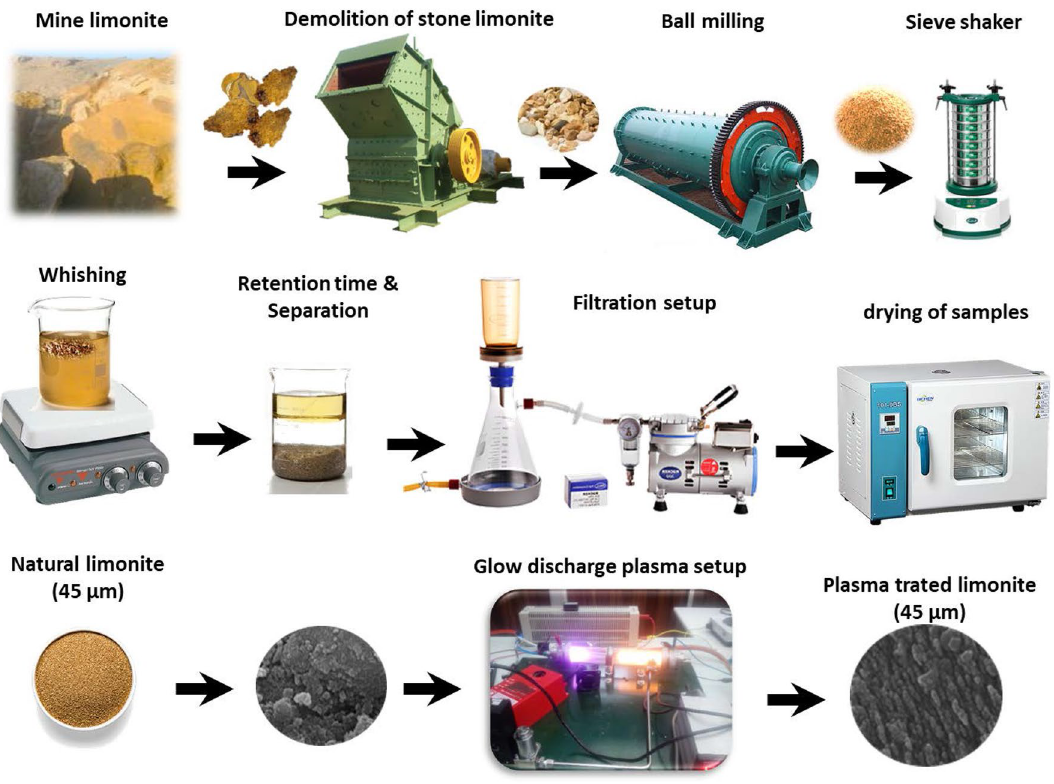
Figure 1. Graphic setup of the plasma treatment system for producing PTL/Ar